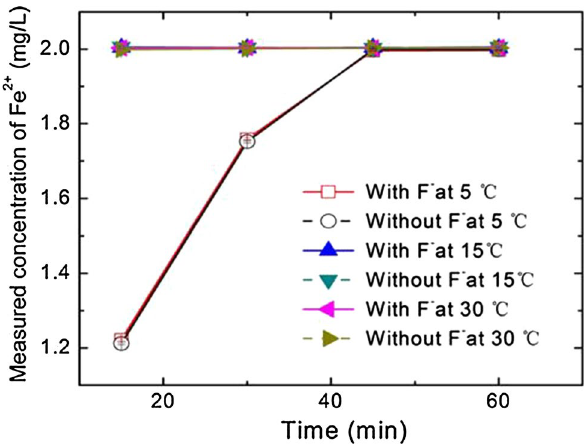
Fig. 4 Effect of light and temperature on chromophoric complexes. Experimental condition: solutions which contained 2 mg/L Fe 2+ , 8 mg/L Fe 3+ and with or without the addition of 36.1 mg/L F − after chromogenesis was kept under different lights or